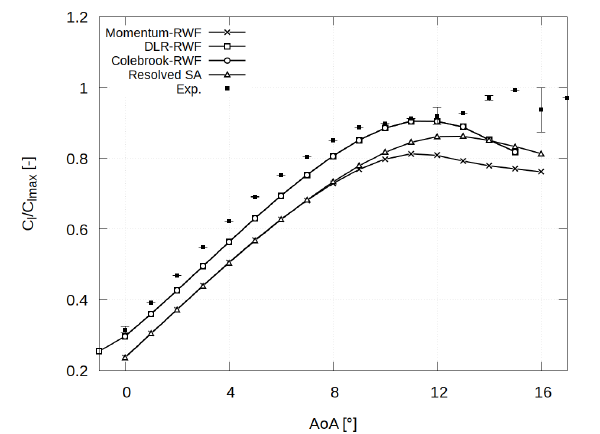
Figure 11. Case 2: C l vs. AoA for different wall functions.